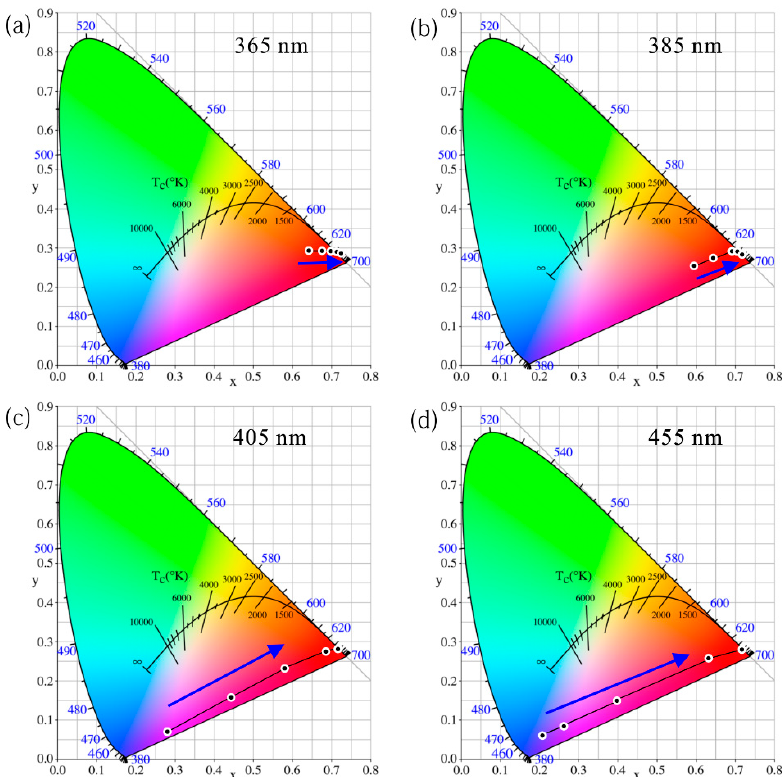
Figure 11. Chromaticity diagram of RQD LED with different QD concentrations under ( a ) 365 nm, ( b ) 385 nm, ( c ) 405 nm, and ( d ) 455 nm of excitation.